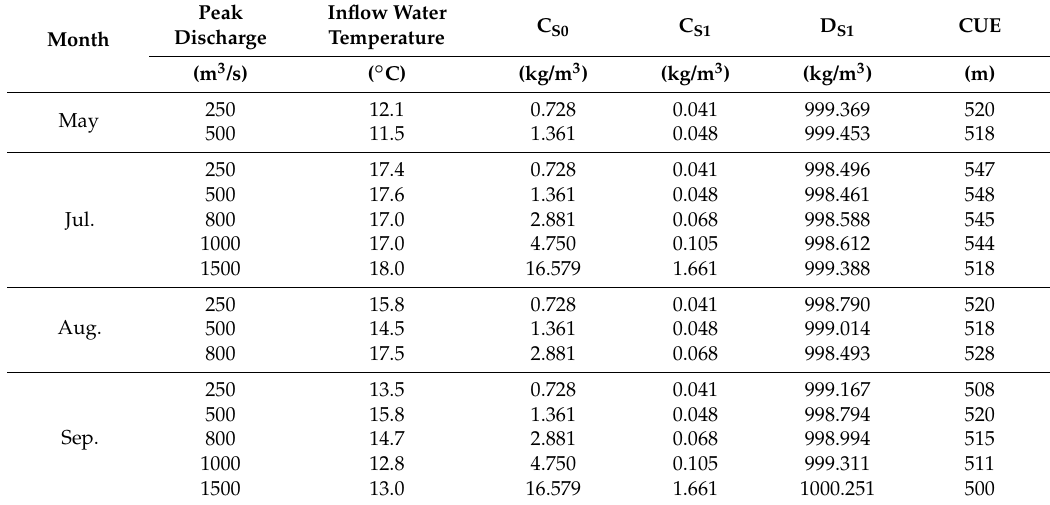
Table 4. Calculated undercurrentelevation (CUE) for different months and peak discharges.